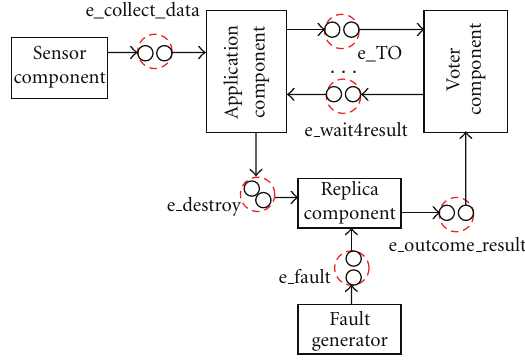
Figure 4: Composition of the DSPN subnets over interface